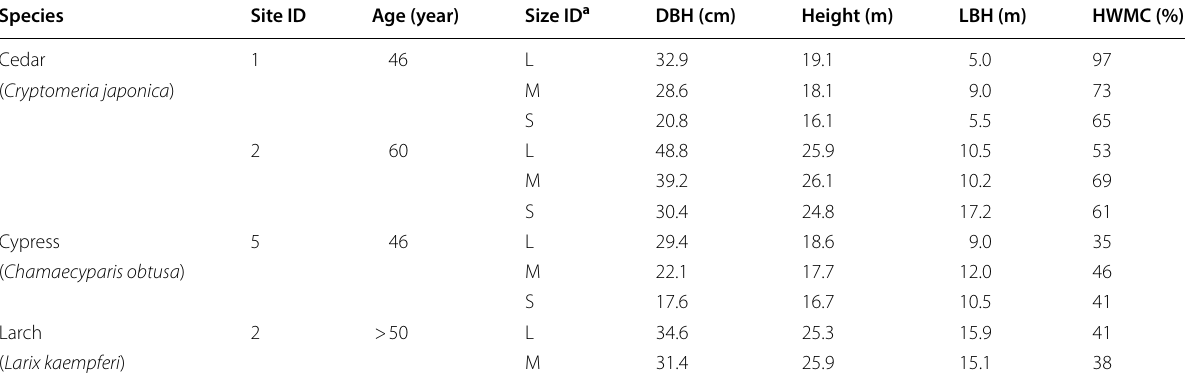
DBH diameter at breast height, LBH lowest branch height, HWMC heartwood moisture content a Relative size of DBH at each sampling site b Mean moisture content of wood disks collected at 2.5 and 4.5 m height